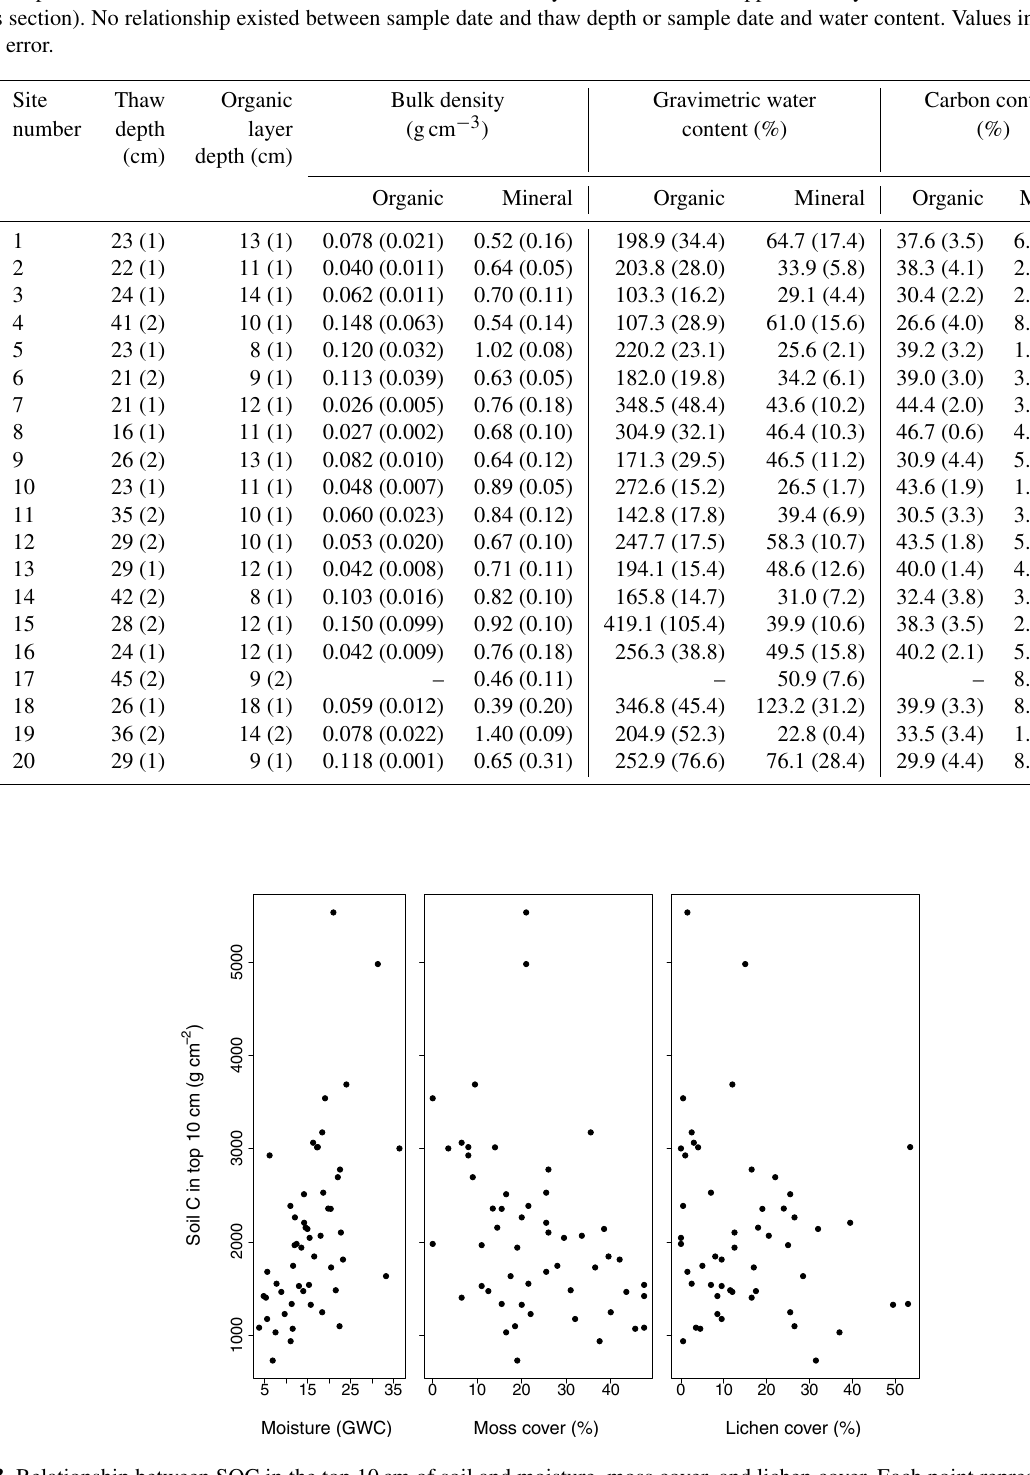
Figure 3. Relationship between SOC in the top 10cm of soil and moisture, moss cover, and lichen cover. Each point represents the average SOC measured at each transect (three transects per site) and its corresponding moisture content or the average moss or lichen cover measured at that